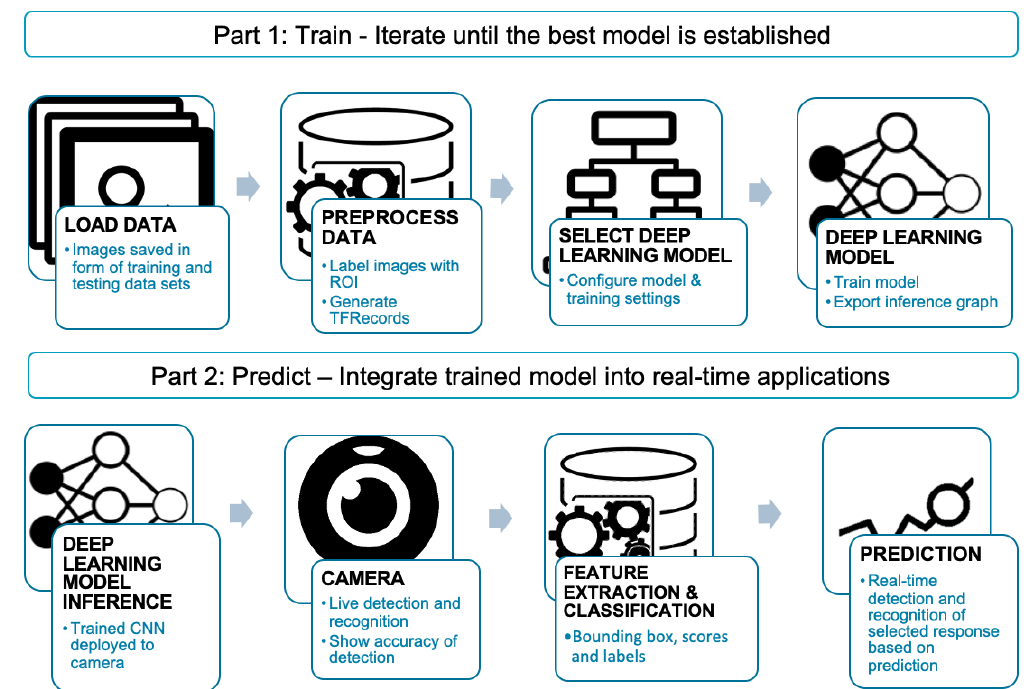
Figure 2. The workflow of the method for the development and application of the model using the TensorFlow Object Detection API.